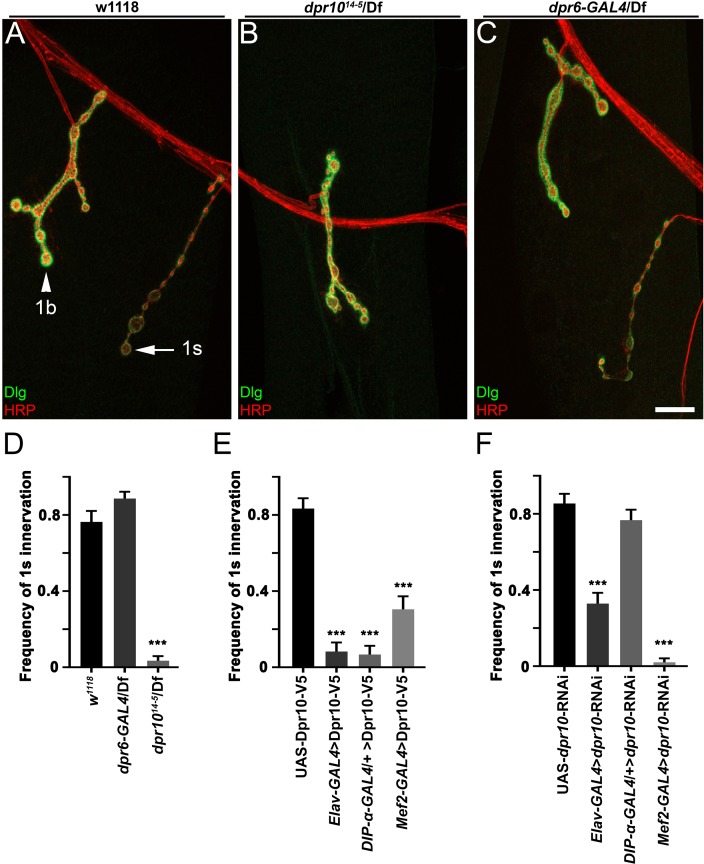
Dpr10 is required for MNISN-1s innervation of muscle 4.(A–C) Larval m4 NMJs labeled with anti-DLG (green) and anti-HRP (red) from (A) control w1118 animals, (B) dpr1014-5/Df null mutants and (C) dpr6-GAL4/Df. The difference in anti-Dlg staining intensity allows us to differentiate 1b and 1s NMJs. 1b and 1s neurons are marked with arrowhead and arrow, respectively. (D–F) Frequency of 1s innervation of m4 from (D) dpr6 and dpr10 mutants and (E) overexpression of UAS-Dpr10-V5 and (F) UAS-dpr10-RNAi. n (animals/hemisegments) = (D) (8/62), (12/70), (11/60) and (E) (8/48), (6/36), (5/30), (8/47), (F) (8/48), (8/48), (10/60), (8/48) (respectively). Calibration bar is 16 µm in A-C. Error bars represent SEM. ***p<0.0001. See also Figure 6—figure supplement 1.10.7554/eLife.42690.017Figure 6—source data 1.Data for graphs in Figure 6 and Figure 6—figure supplement 1.